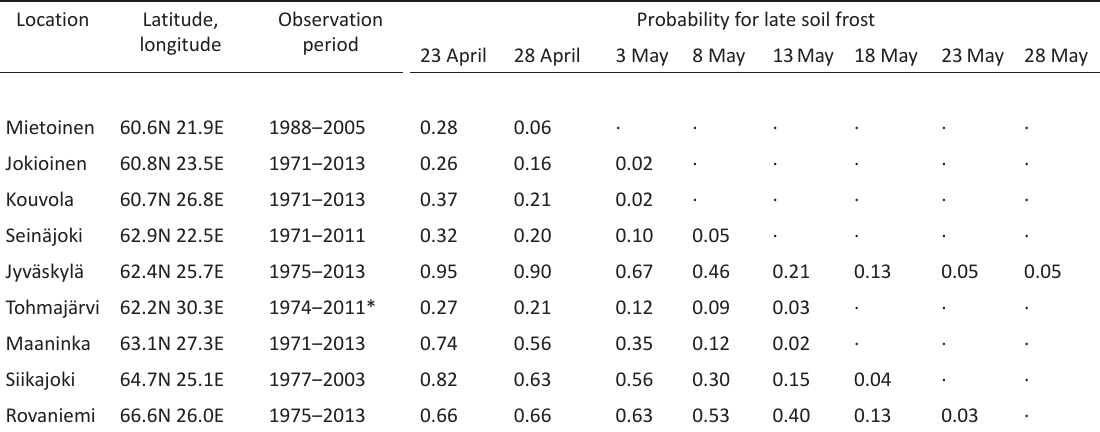
Table 1. Probabilities of late spring soil frost (measured soil temperature ≤ 0 °C at 20 cm soil depth) at nine locations in Finland with the duration of each observation period (Finnish Meteorological Institute). Dot indicates no likelihood. Location Latitude, Observation longitude